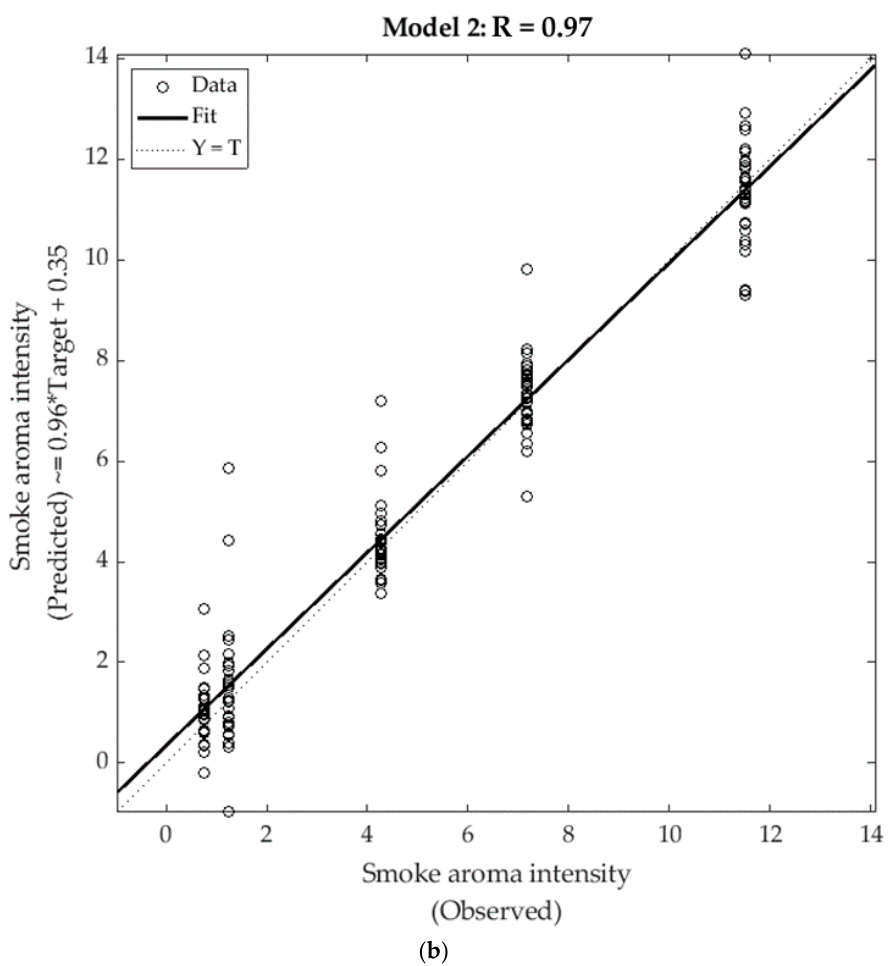
Figure 5. Overall correlations of the two models to predict: ( a ) the levels of volatile aromatic compounds (Model 1) and ( b ) levels of smoke aroma intensities (Model 2).